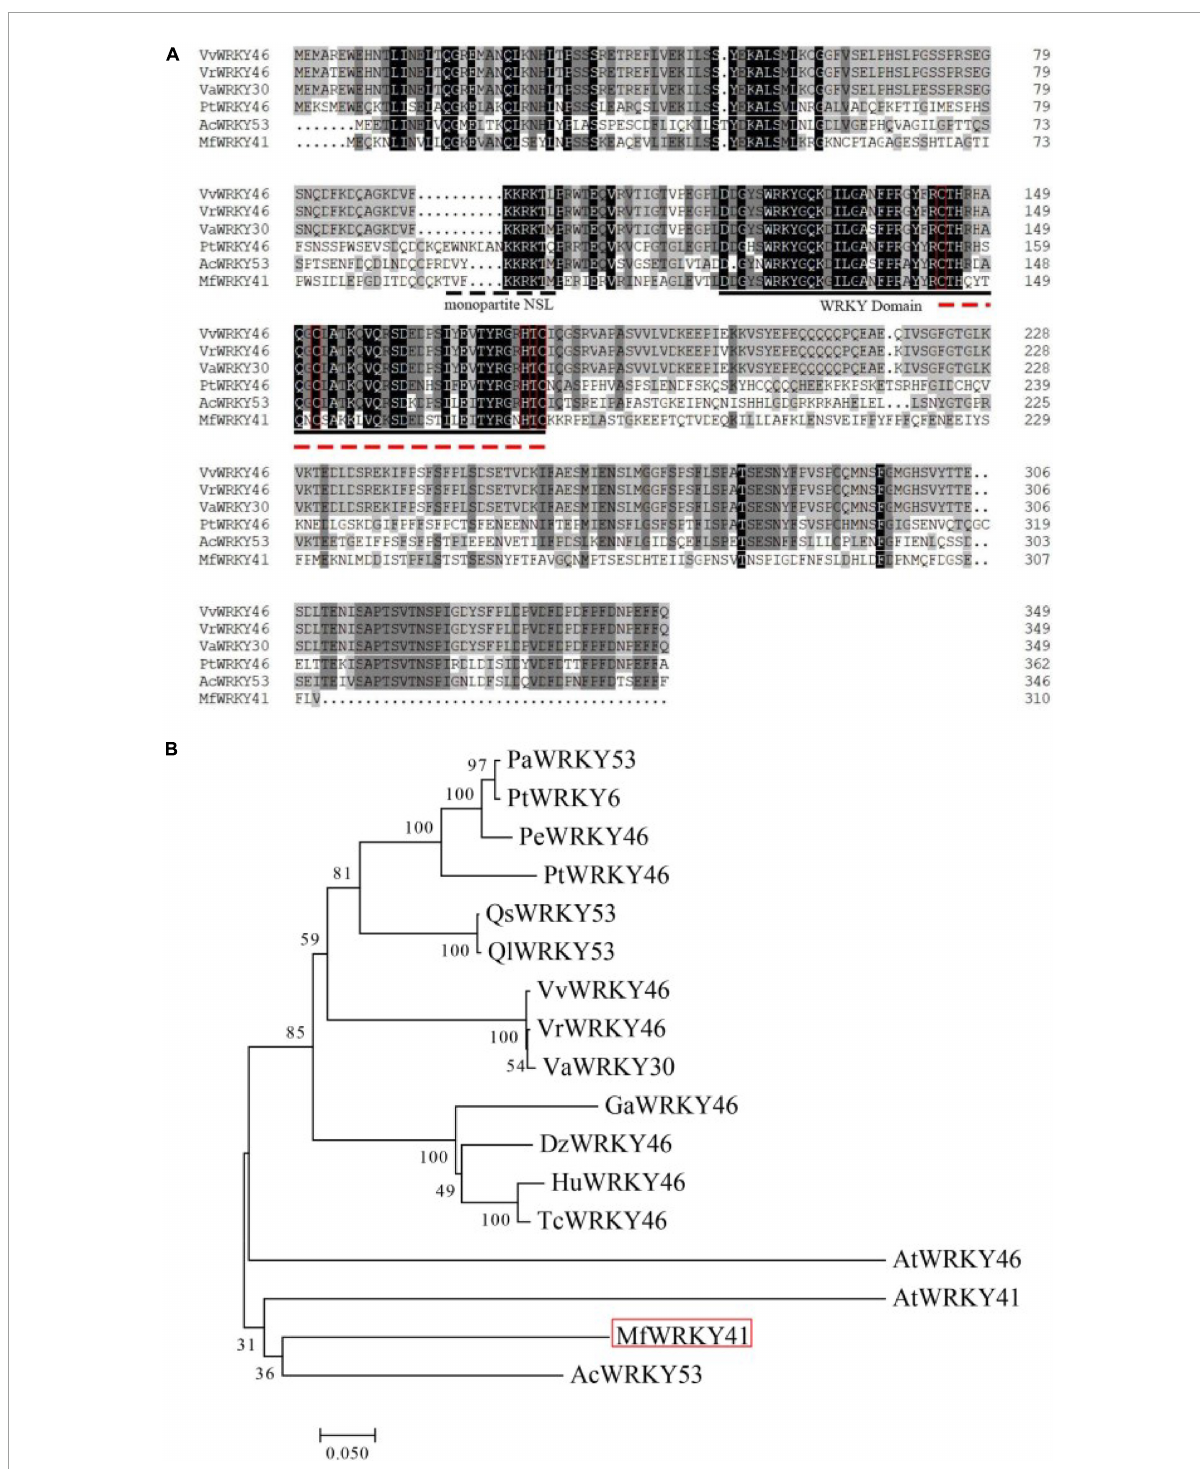
FIGURE1 Multiple sequence alignment and phylogenetic analysis of MfWRKY41. (A) Black and gray shade showed identical and similar amino acids, respectively. Amino acids marked by the dashed line was the deduced NLS. WRKY domains are represented by solid black line. Zinc finger structure is represented by red dotted lines and red boxes. (B) Phylogenetic reconstruction using the neighbor-joining method (Jones-Talor-Thornton model) of MfWRKY41 and several highly homologous WRKY proteins. The MfWRKY41 was marked by red box. The first two letters of sequence name represented initials of Latin name of species from which the sequence originates. The full Latin name and the GenBank accession numbers were listed in Supplementary Table 1